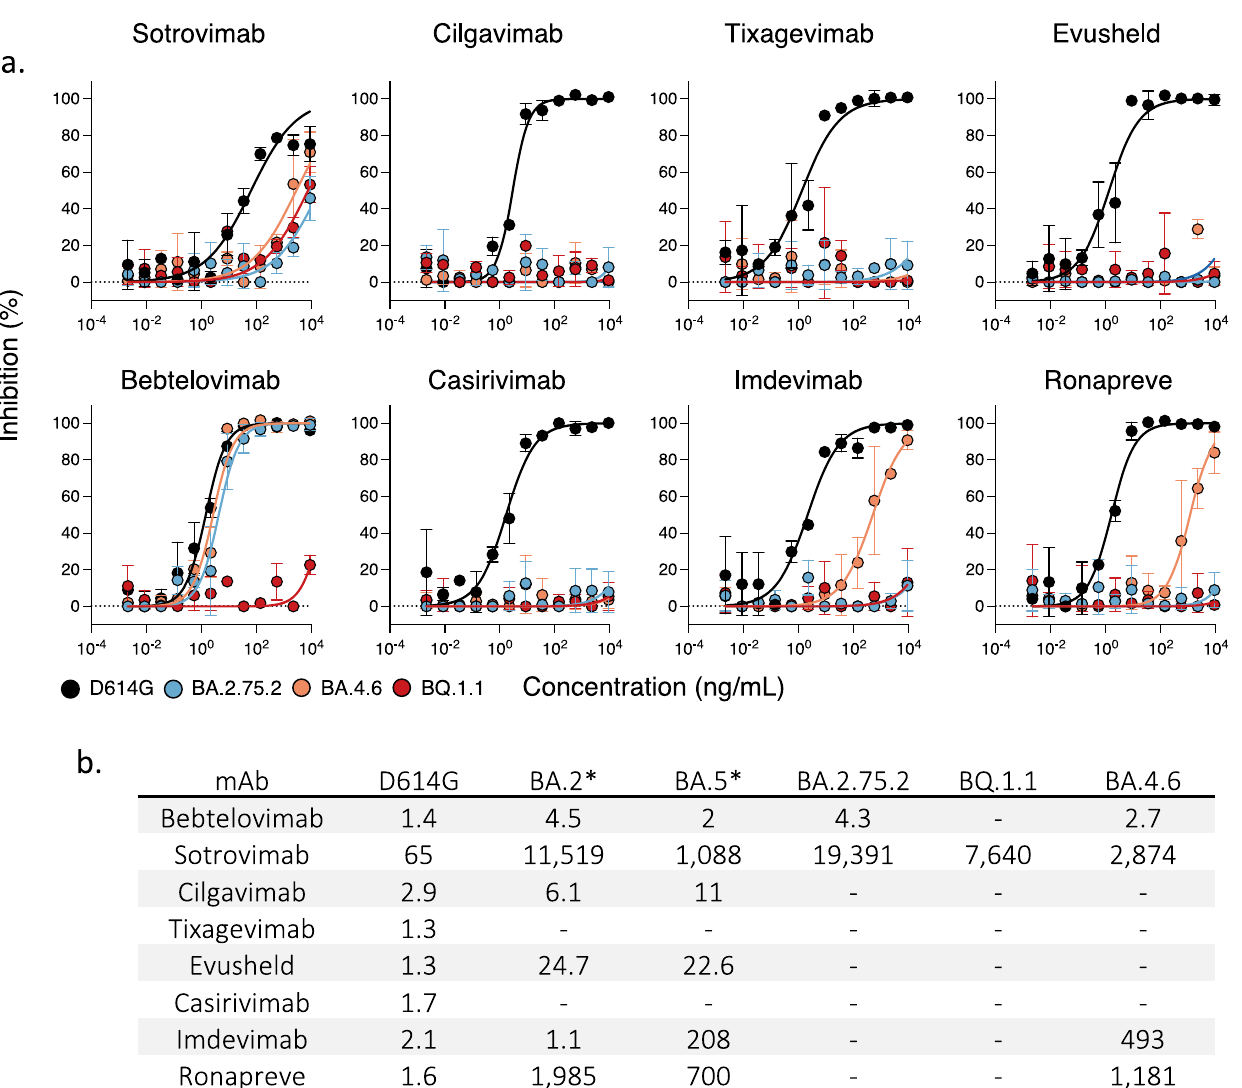
Fig. 3 | Neutralization activity of therapeutic monoclonal antibodies against BQ.1.1, BA.2.75.2, and BA.4.6. a . Neutralization curves of monoclonal antibodies. Dose – response analysis of the neutralization by the indicated antibodies or their clinical combinations. Evusheld: Cilgavimab and Tixagevimab. Ronapreve: